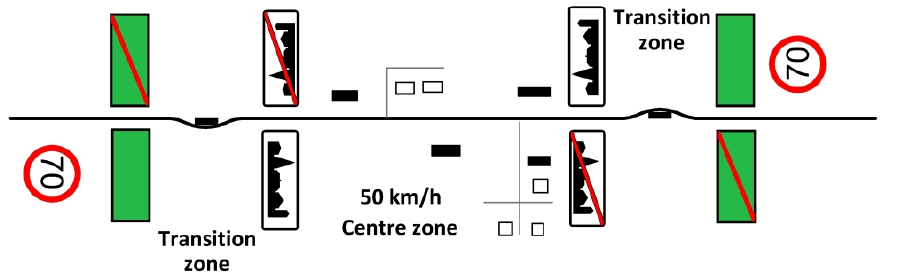
Figure 2. Tra ffi c management scheme with 70 km / h speed limit on test sections with installed on-road Figure 2. Traffic management scheme with 70 km/h speed limit on test sections with installed on-road chicanes (based on the analysis of the recommendations of [1,2,5,19,42,53]). Energies 2020 , 13 , x FOR PEER REVIEW chicanes (based on the analysis of the recommendations of [1,2,5,19,42,53]).